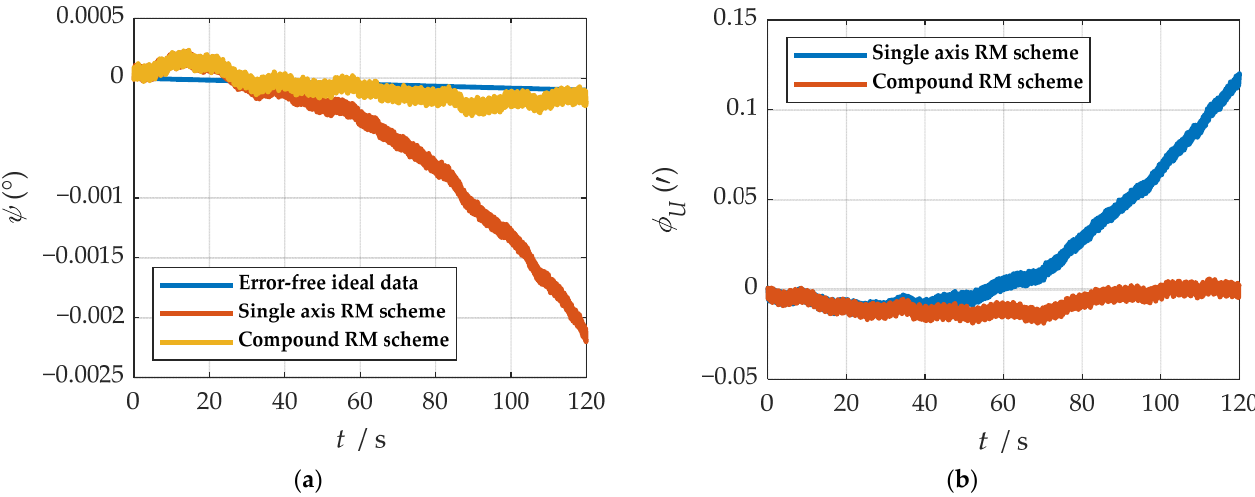
Figure 20. The navigation results comparison of the rotation scheme: ( a ) comparison of calculation results of pitch angle; ( b ) comparison of calculation results of up misalignment